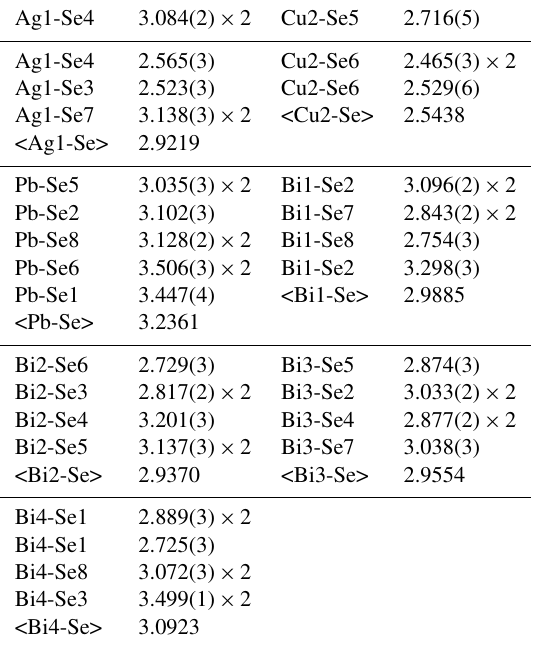
Table 5. Selected interatomic distances (Å) for luxembourgite from Bivels,